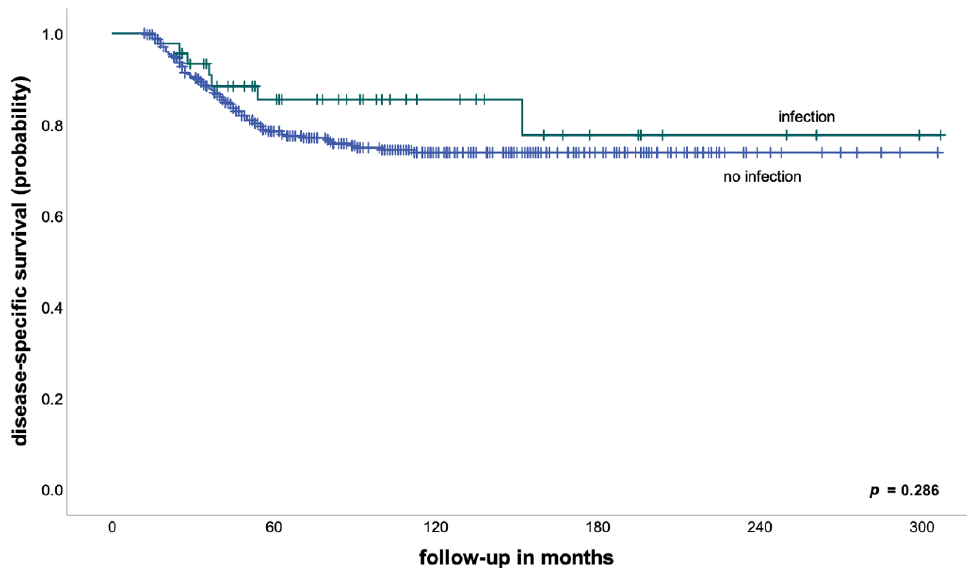
Figure 1. Disease-specific survival in patients with and without early postoperative infections (the entire cohort) .